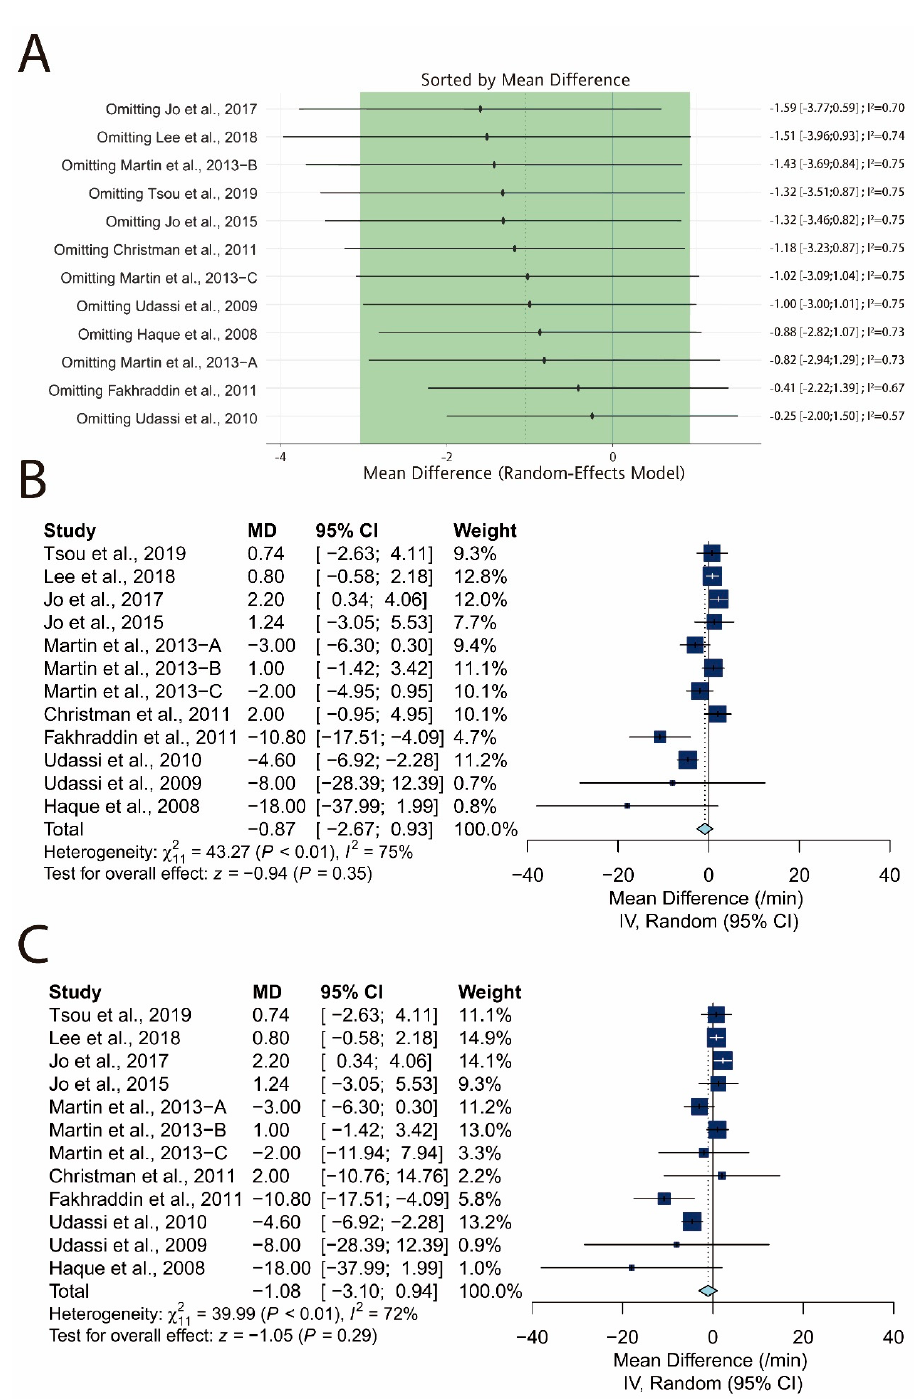
Figure 14. Sensitivity analysis of chest compression rate. ( A ) Leave-one-out analysis; ( B ) forest plot with the correlation set as the highest observed (0.95); ( C ) forest plot with the correlation set as 0.